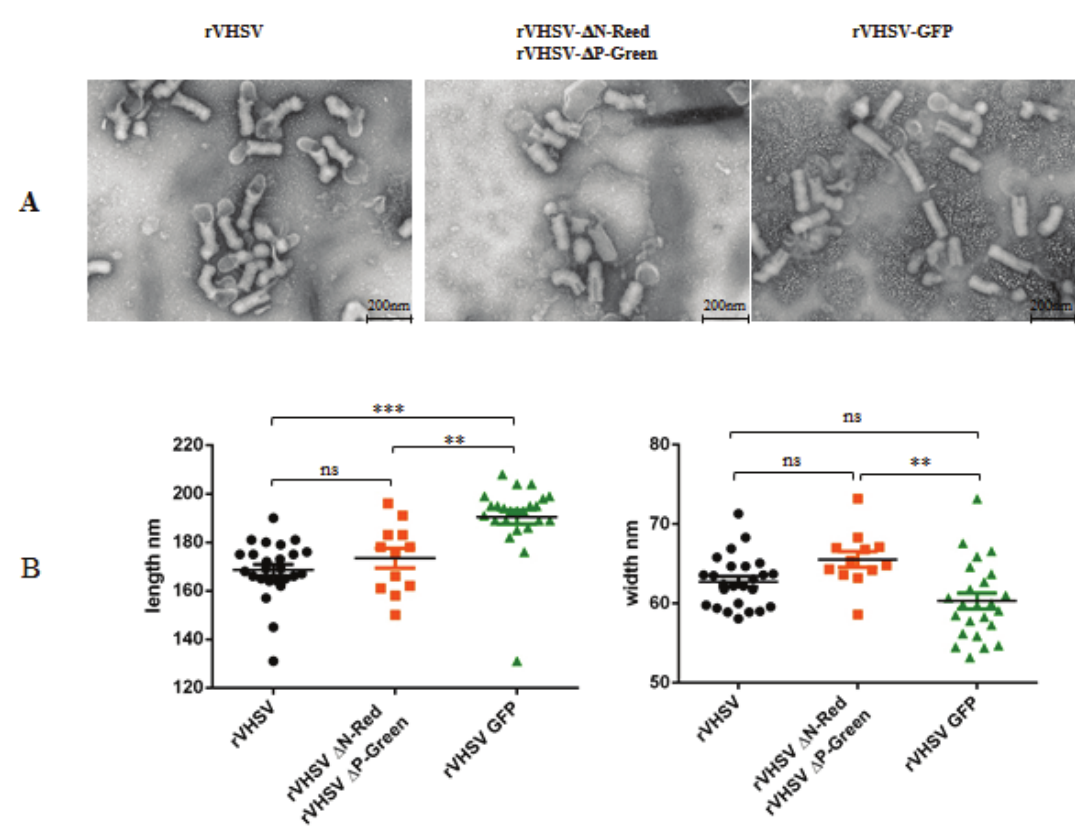
Figure 6. Electron microscopy observations of various recombinant VHSV. Recombinant rVHSV, rVHSV-GFP, rVHSV- Δ N-Red + rVHSV- Δ P-Green were semi-purified onto a 25% sucrose-cushion as